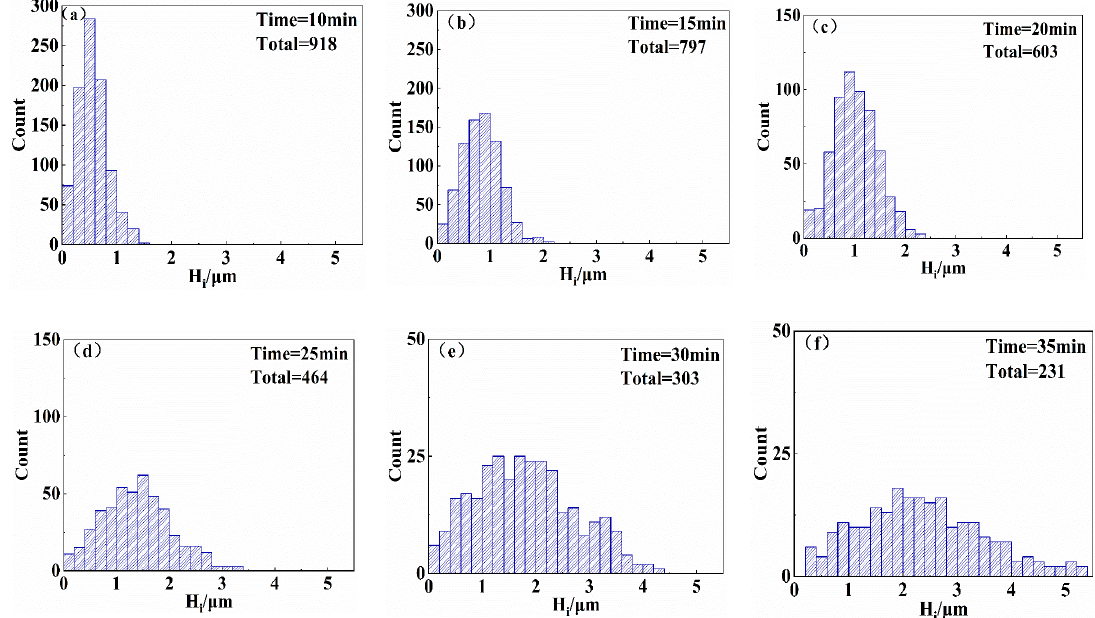
Figure 5. Height distributions of pyramids on the surfaces of the wafers: ( a ) Etching for 10 min, ( b ) etching for 15 min, ( c ) etching for 20 min, ( d ) etching for 25 min, ( e ) etching for 30 min, and ( f ) etching for 35 min